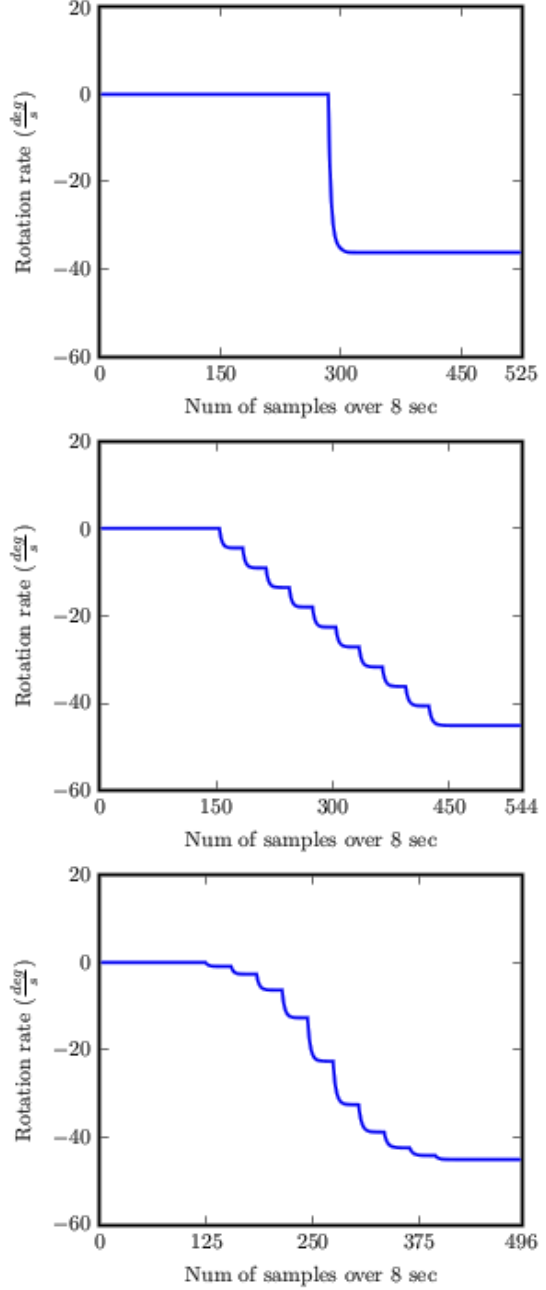
Figure 11. The rotation rate of the three transition cases for the Blender model. Top: no transition; Middle: clothoid transition; Bottom: S-shaped